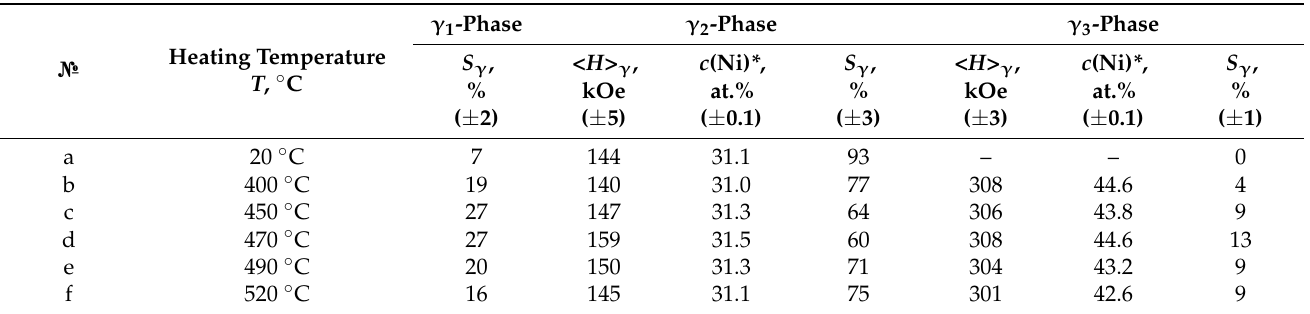
Table 2. Mean hyperfine magnetic field < H >, Ni concentration c (Ni) and integral intensities S for Mössbauer spectra components γ 1 , γ 2 and γ 3 (shown in Figure 4a–f) of the FeNi 31.1 alloy after the slow heating of quenched martensite up to temperature T with a further fast heating up to 600 ◦ C in the salt